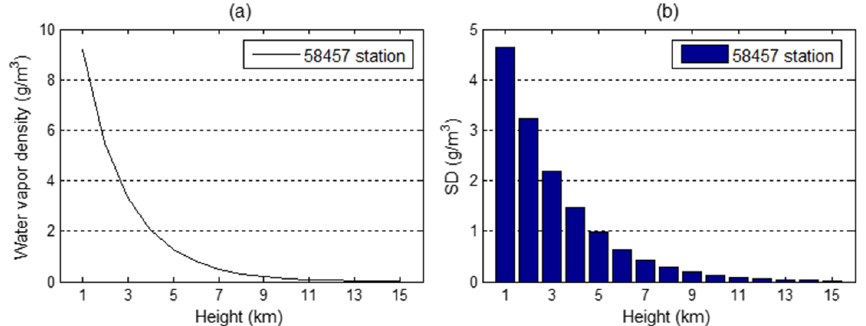
Figure 5. Average water vapor density and SD derived from the 58457 radiosonde for the 10years from 2004 to 2014.